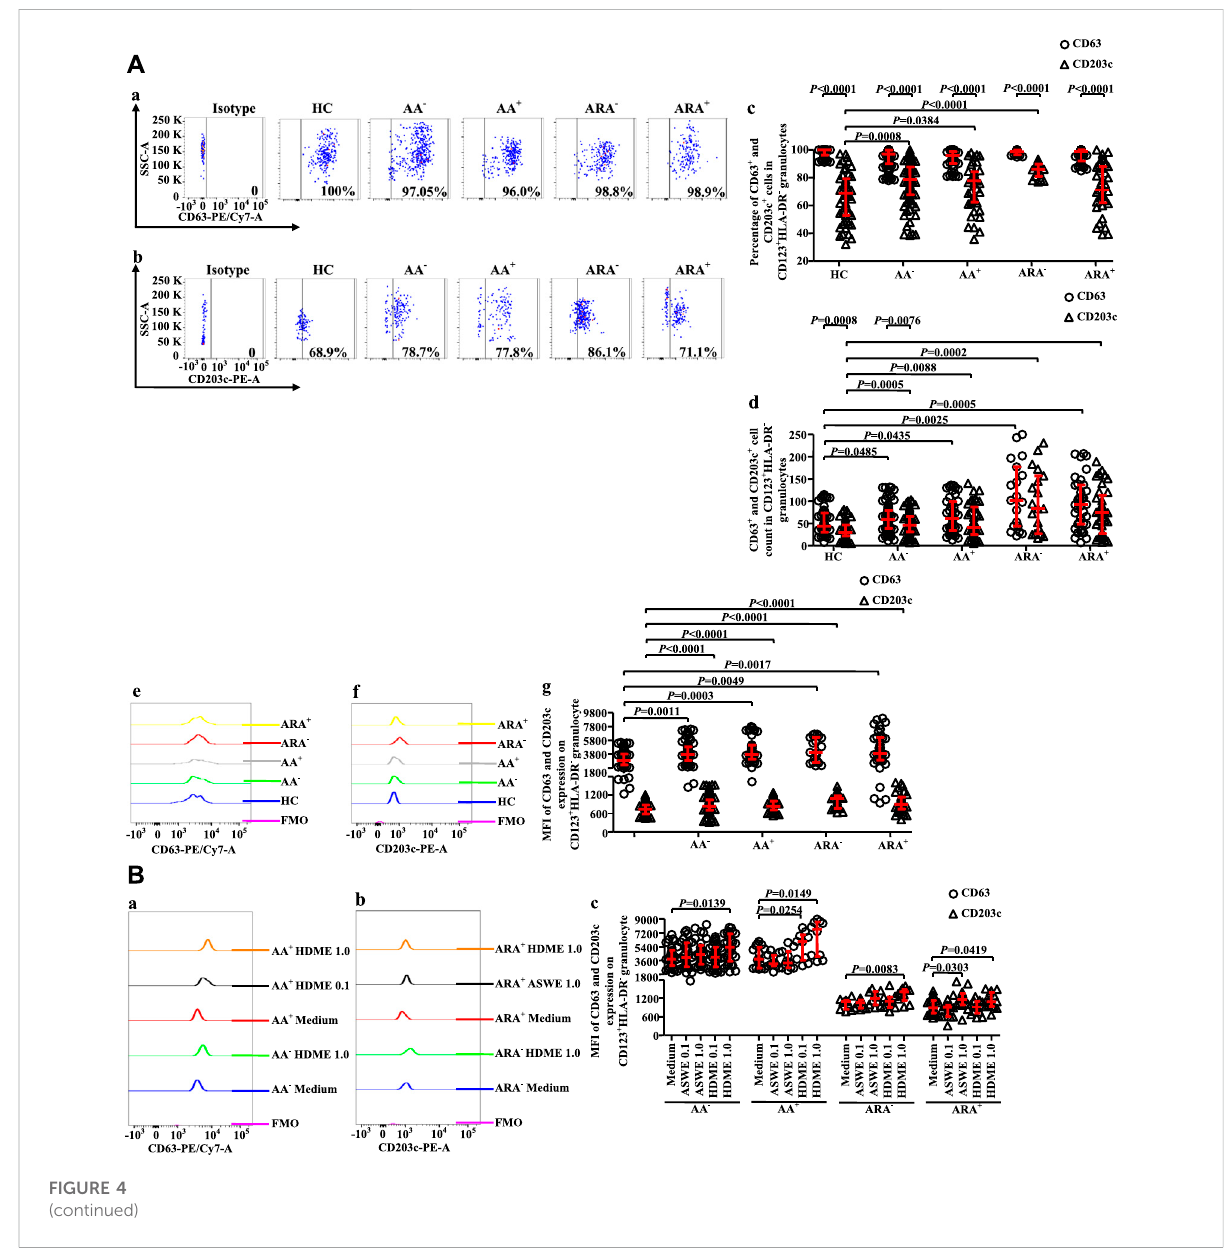
PBMC (Figure 4Cd) in the blood of AA − , AA + , ARA − , and ARA + patients